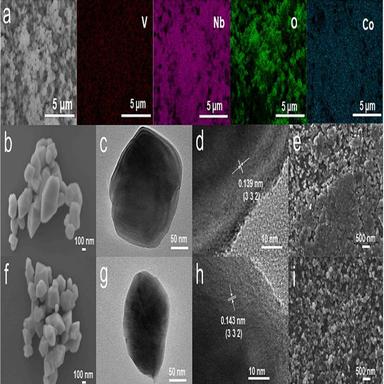
(a) EDS mappings of V, Nb, O and Co in CNO-V0.005; (b) SEM images of CNO; (c) TEM images of CNO; (d) HRTEM image of CNO; (e) SEM images of CNO after cycling; (f) SEM images of CNO-V0.005; (g) TEM images of CNO-V0.005; (h) HRTEM image of CNO-V0.005; (i) SEM images of CNO-V0.005 after cycling.